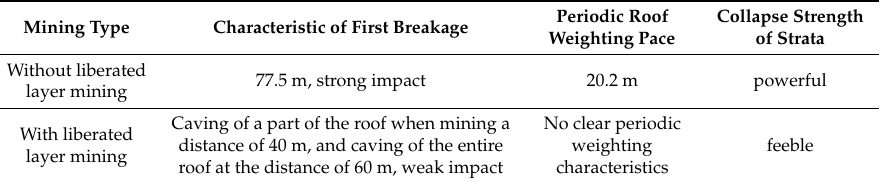
Table 1. Comparative analysis on the fracture characteristics of the overlying strata.